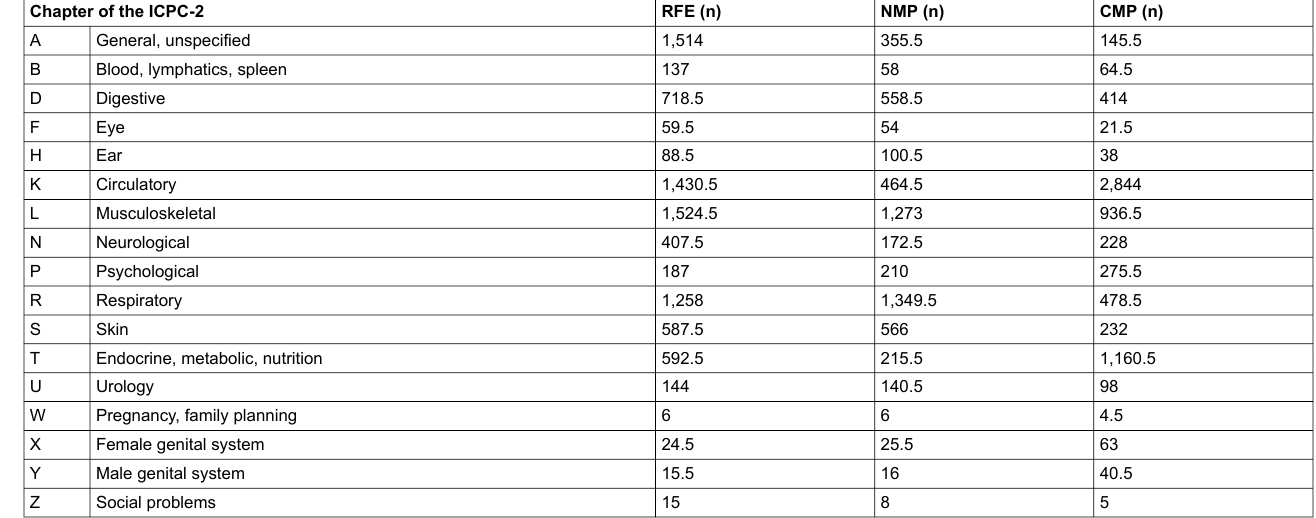
Table 1: The average numbers of the reasons for encounter (RFE), the new managed problems (NMP) and the chronic managed problems (CMP) among the chapters of the ICPC-2 according to the coding of two raters. Chapter of the ICPC-2 A General, unspecified Blood, lymphatics, spleen